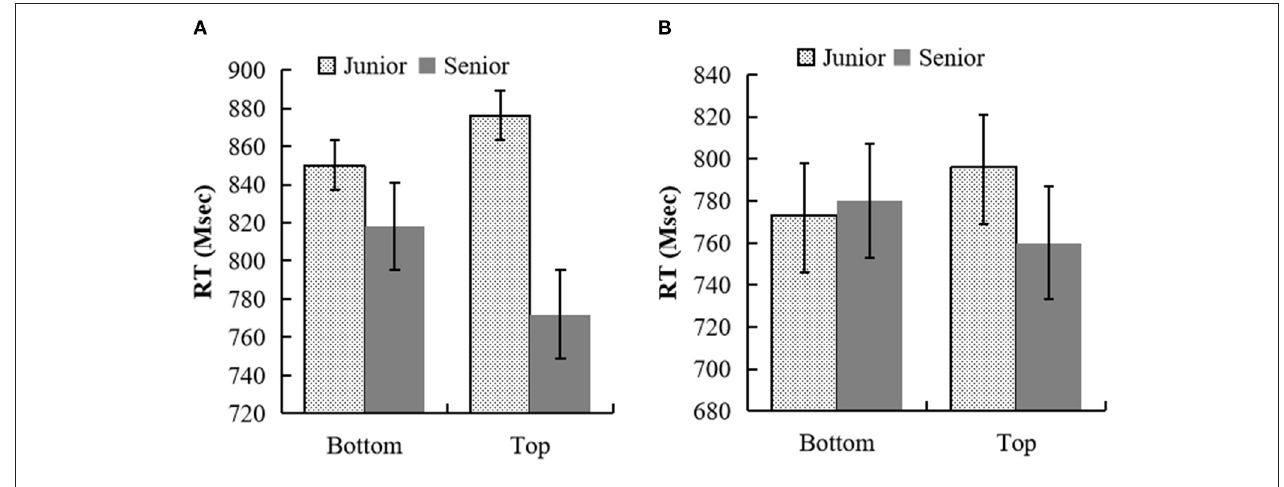
FIGURE 1 | (A) RTs (in proportions) for the semantic judgment task of kin terms in experiment 1a. (B) RTs (in proportions) for the target letter identification task (p–q judgment) in experiment